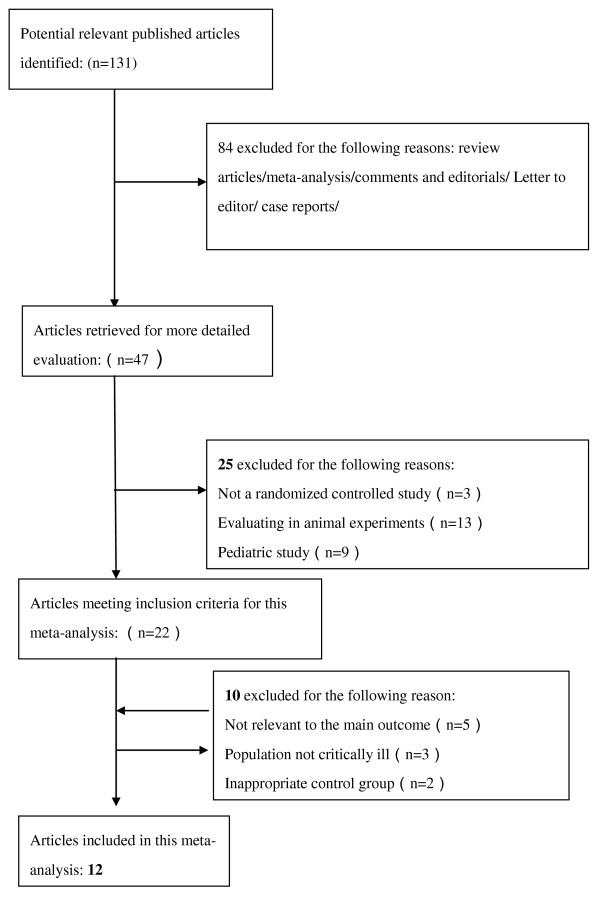
Flow chart of study selection. Pooled ORs were calculated using the Mantel-Haenszel (M-H)Estimator. Study-level data were pooled using a random-effects model when I2 was > 50% or a fixed-effects model when I2 was < 50%.